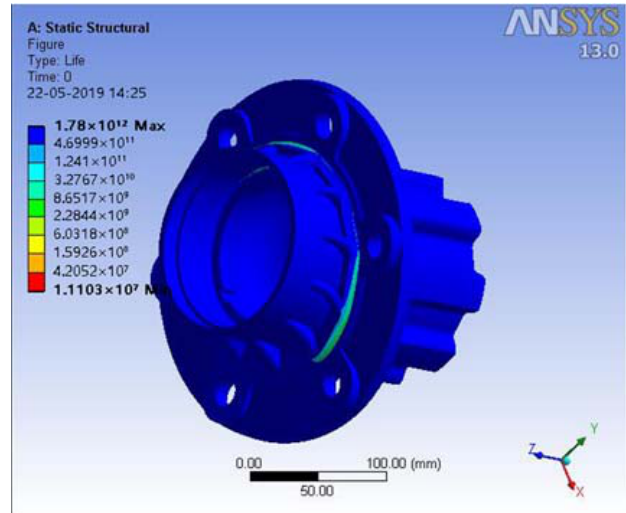
Figure 8. Analysis on the number of life cycles.